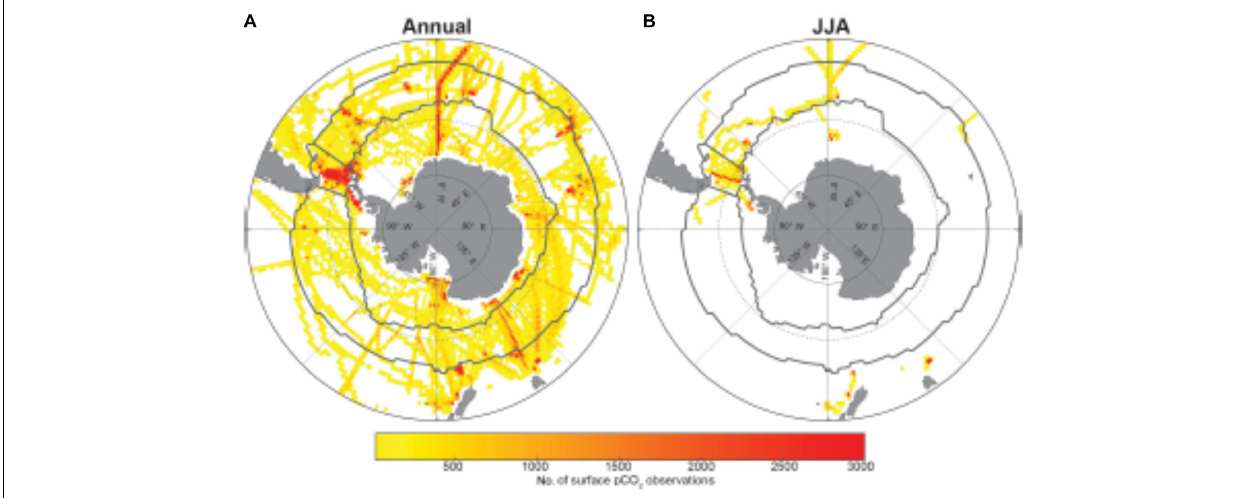
FIGURE 3 | Seasonal sampling bias for surface pCO 2 observations in the Southern Ocean (Fay et al., 2018). The total annual observations (A) are dominated by summer observations whereas winter observations (B) are dominated by the Drake Passage and the more recent dedicated winter cruises by the South African SA Agulhas